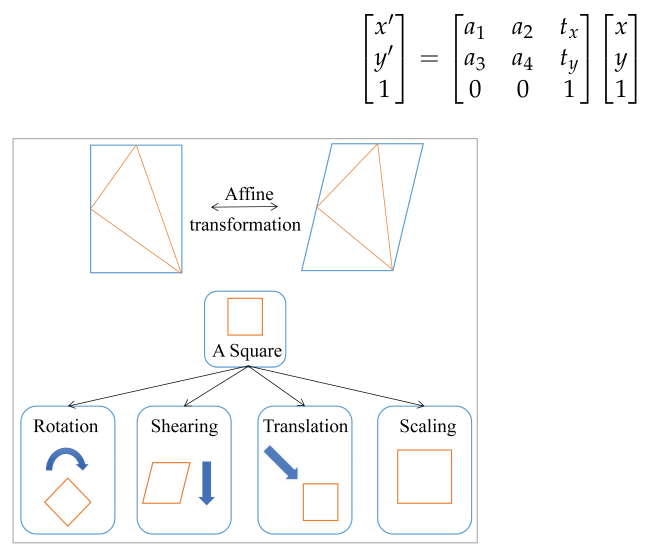
Figure 3. Schematic diagram of affine transformation. Image affine transformation can keep the straightness, parallelness, and relative position unchanged. Affine transformation includes rotation, shearing, translation, and scaling,